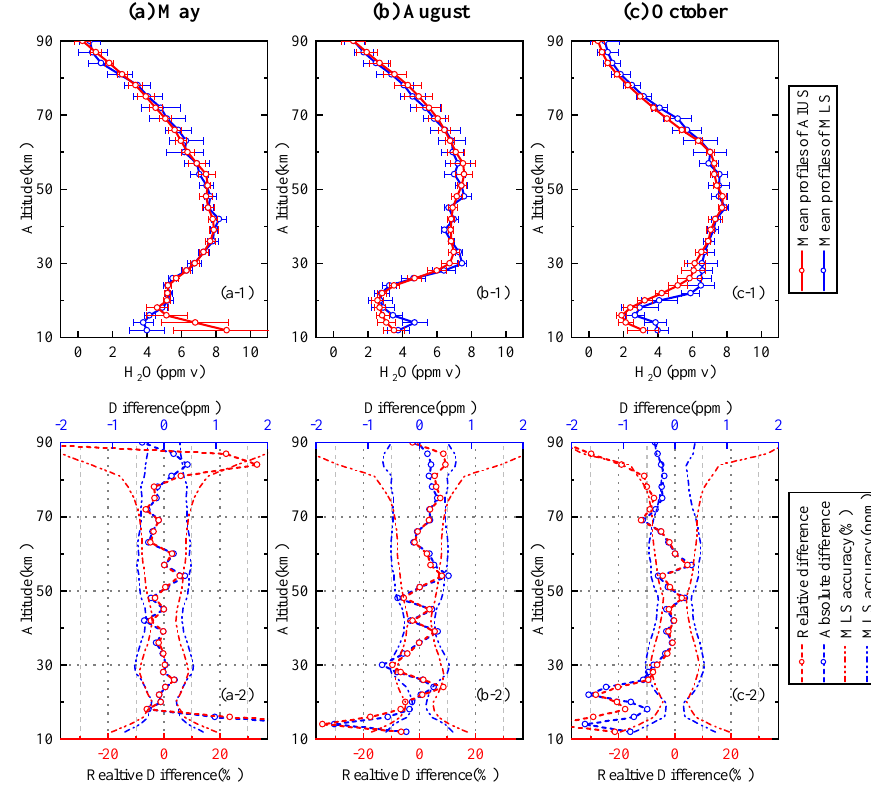
Figure 14. Same as Figure 12 except for 70 ◦ –75 ◦ S in May, August, and